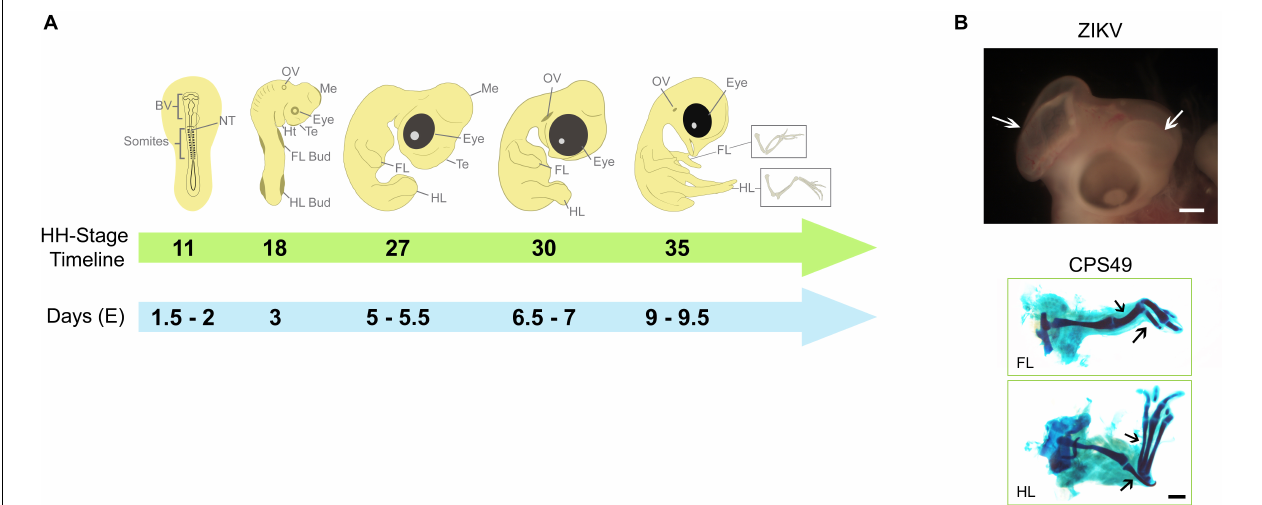
FIGURE 1 | Key developmental structures of the chicken embryo and their timings. (A) The chicken embryo develops rapidly, the developing heart, limbs, eyes and brain can be used to evaluate teratogenic potential of teratogens such as thalidomide and Zika virus. By HH Stage 11 (Embryonic day E1.5-2), brain vesicles are developing and exposure to potential teratogens that might affect brain development may confirm their harmfulness, which become more evident by HH Stages 27 - 30. By HH Stage 18 (E3), limb buds can be observed and used to test substances with potential to affect limb development, which can be observed throughout development and confirmed by HH Stage 35 (E9-9.5), when cartilage elements can be better visualized. (B) Examples of teratogenic exposure and their effects on the development of chicken embryo; ZIKV induces to brain defects (white arrows; described previously in Wachholz et al., 2021) and CPS49, an antiangiogenic analog of thalidomide, which causes limb defects with reduction or absence of cartilage elements (black arrows; described previously in Therapontos et al., 2009). Images in B are from archives from Lucas Fraga’s Lab (ZIKV) and Neil Vargesson’s Lab (CPS49). BV, Brain Vesicles; NT, Neural Tube; FL, Forelimb; HL, Hindlimb; Te, telencephalon; Me, Mesencephalon; Ht, Heart; OV, Otic